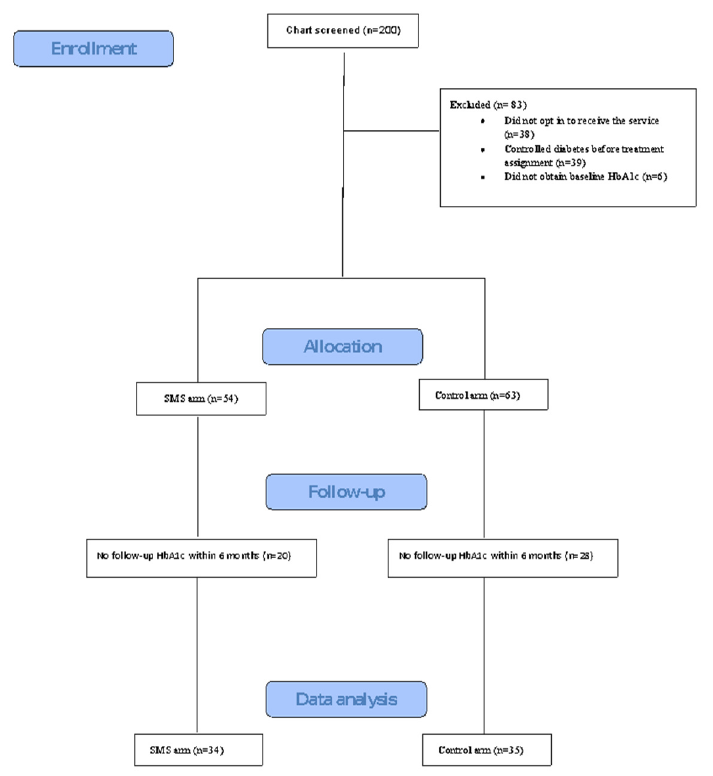
Figure 1. Flowchart of participant recruitment.